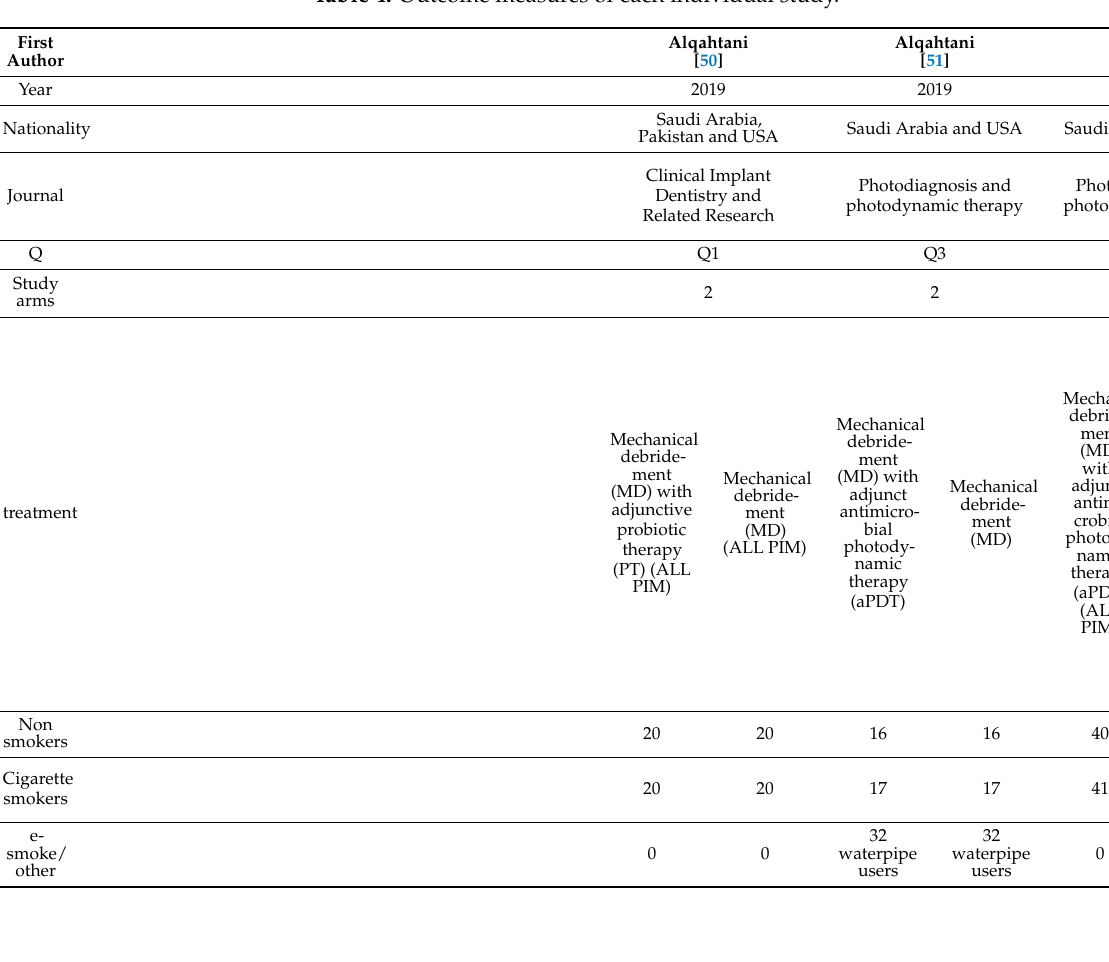
Table 4. Outcome measures of each individual